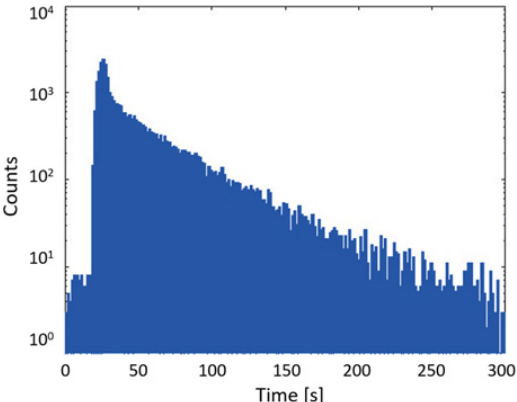
Figure 7. Neutron rate at the West-1 port as registered with the oscillating UCN detector ( f = 15 Hz). The proton pulse on the spallation target starts at time = 20 s.